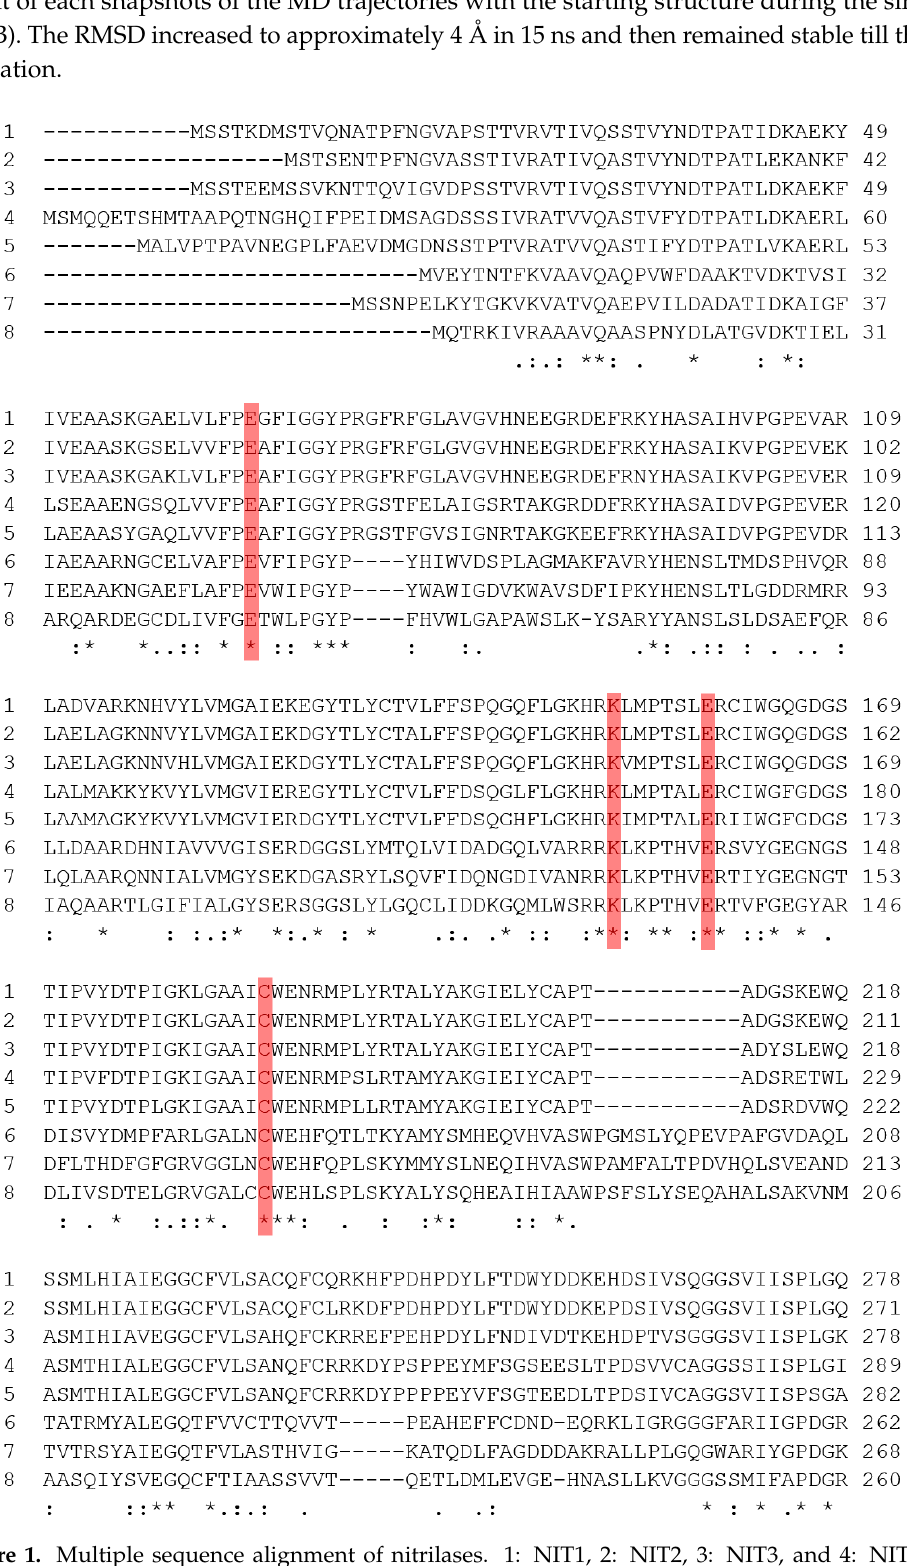
Figure 1. Multiple sequence alignment of nitrilases. 1: NIT1, 2: NIT2, 3: NIT3, and 4: NIT4 of Arabidopsis thaliana , 5: NIT4 of Nicotiana tabacum , 6: nitrilase of Rhodococcus rhodochrous J1, 7: nitrilase of Rhodococcus rhodochrous K22, 8: nitrilase of Alcaligenes faecalis JM3. The active site residues conserved are shown in the red bar. The symbols “*, :, and .” represent the residues’ perfect identity, high similarity, and low similarity at the site, respectively.